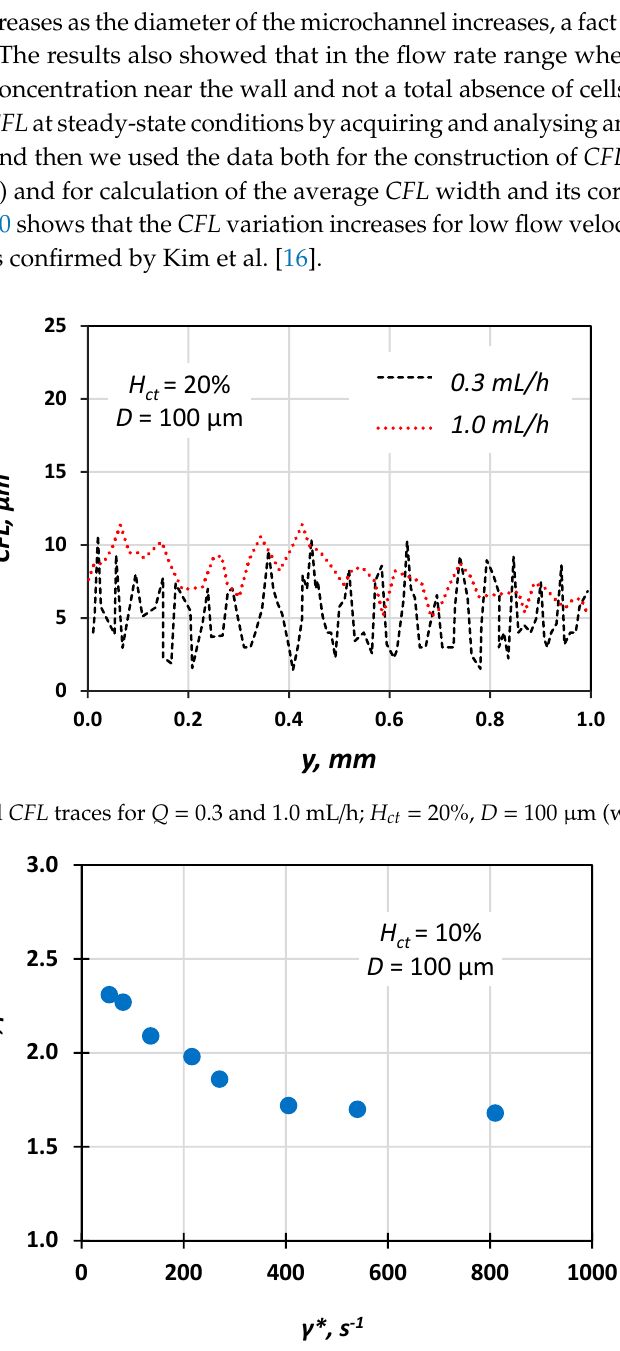
Figure 10. Typical variation of CFL standard deviation (SD) vs. pseudo shear rate ( H c t = 10%, D = 100 μ m).